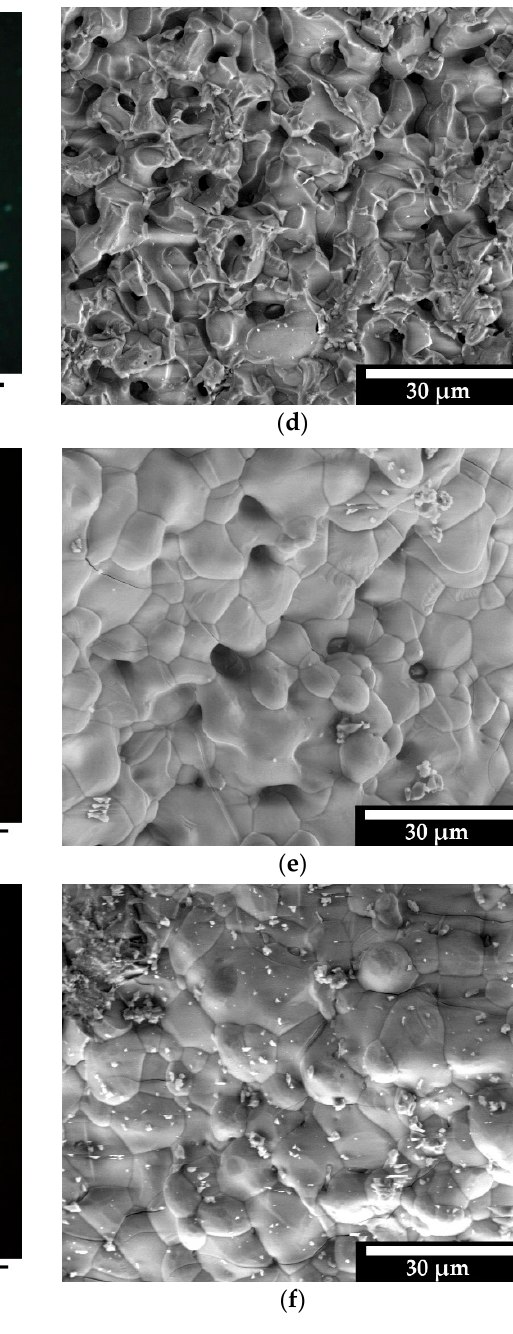
Figure 2. Macro and microstructure of the scaffolds; stereomicroscopic images of all three sizes: ( a ): 500 µm empty space; ( b ): 750 µm; and ( c ): 1000 µm. microstructures taken with FEI QUANTA 250 FEG, 20 kV, 3200x magnification of the surface from sample: ( d ): 500 µm; ( e ): 750 µm; and ( f ): 1000 µm.